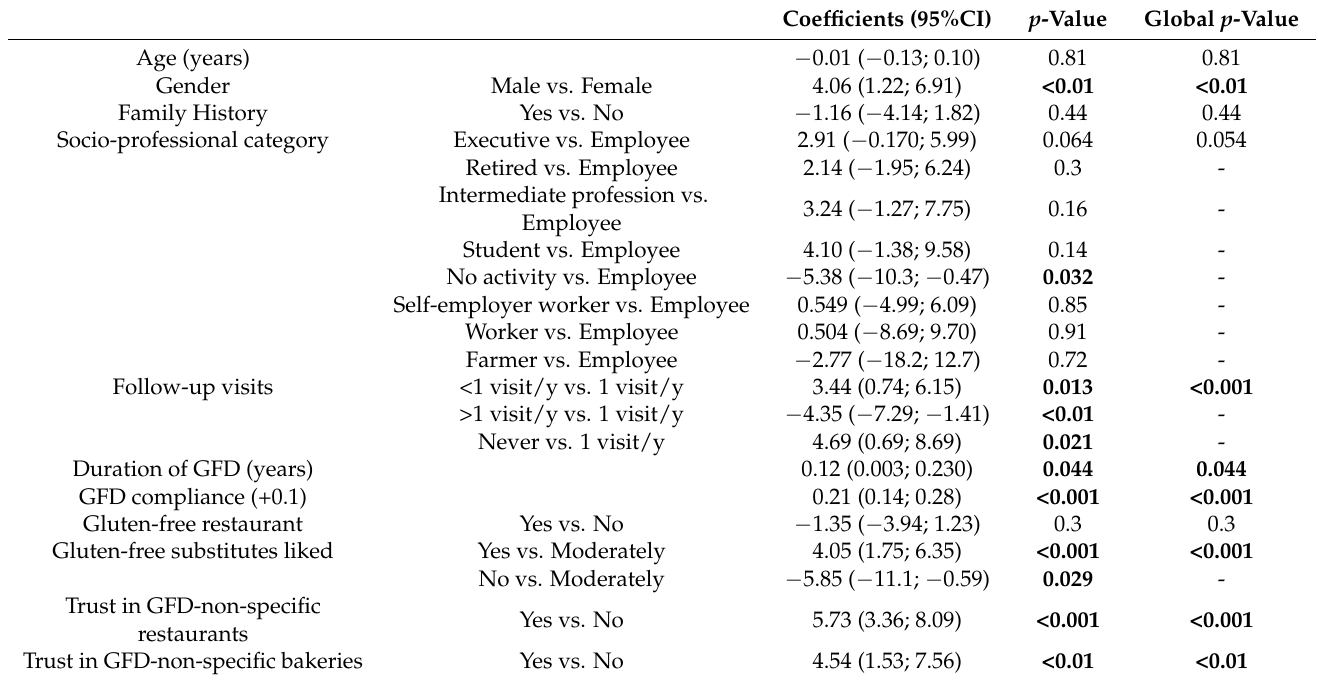
Table 5. Multivariate analysis to identify factors related to total F-CDQ